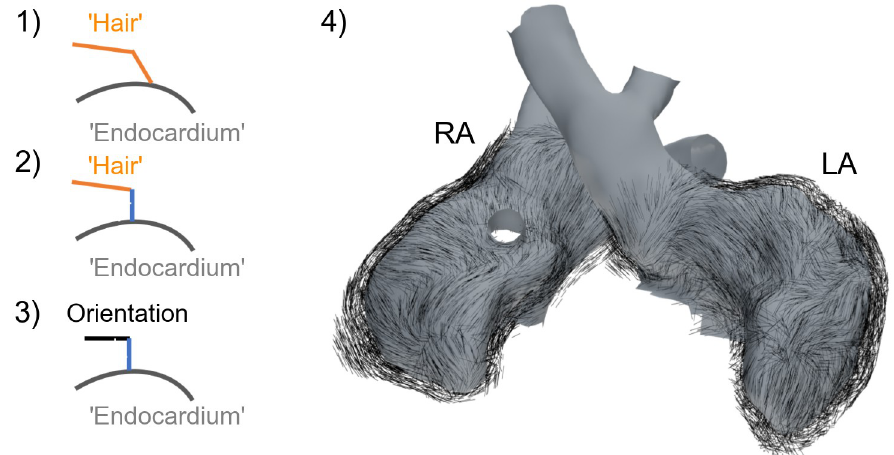
Fig 3. Workflow to generate atrial myocyte orientation. Using a hair particle system with two segments (2 line elements) in Blender [18], the hair was groomed to visually recreate the myocyte orientation published by Kharche et al . [25], step 1. Then the segment connected to the endocardial surface is corrected to be in normal direction, step 2. By assuming that the myocyte sheet direction is in parallel and the sheet-normal direction is in normal direction in respect to the endocardial surface, we can correct the second segment such that it is orthogonal to the other two directions, step 3. Finally, the segment connected to the endocardial surface is removed, leaving the second segment depicting the myocyte orientation (not defined for vessels), step